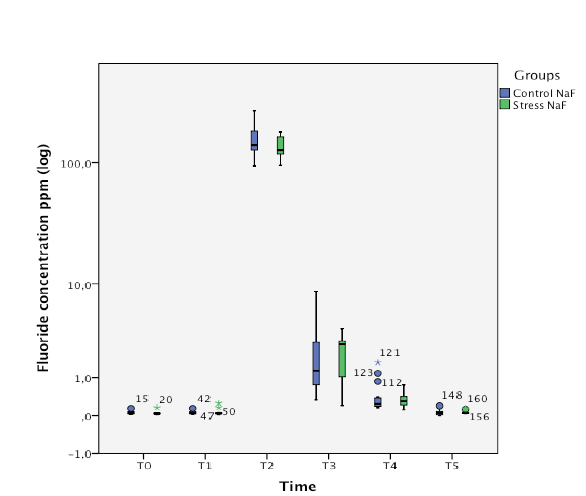
Figure 5b. Fluoride concentration kinetics from T0 to T5 for all NaF control and stress groups (logarithmic scale). The increase in bioavailable fluoride was lower in both stress groups compared with the resting control